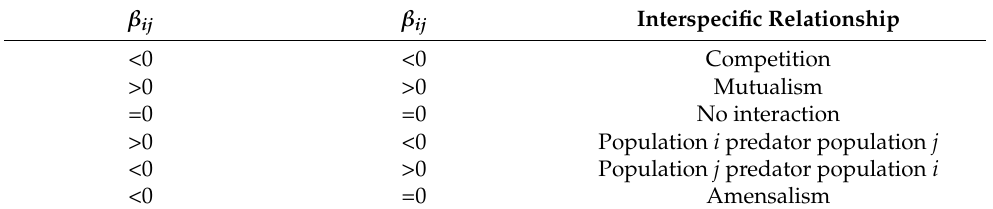
Table 2. Interaction between the various